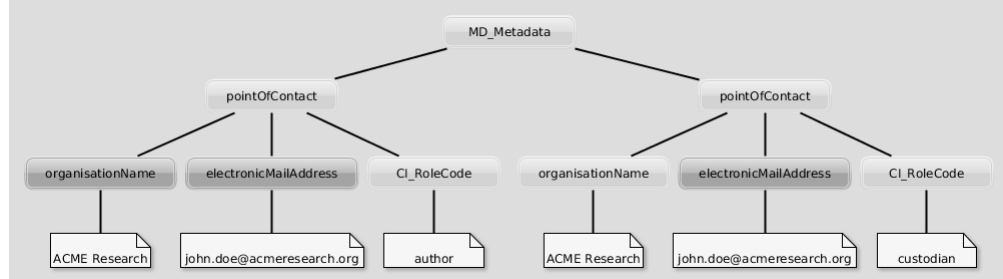
Figure 1. Nodes in ISO-compliant metadata indicating “John Doe” as both creator and custodian of resource “Dataset